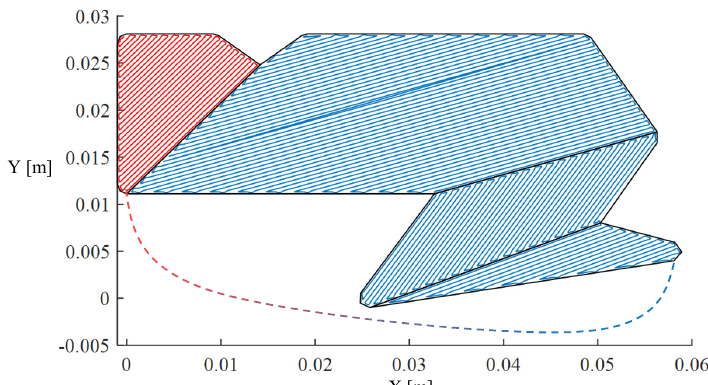
Figure 21. Executable path planned by the decomposition path planner and the smoothing algorithm.